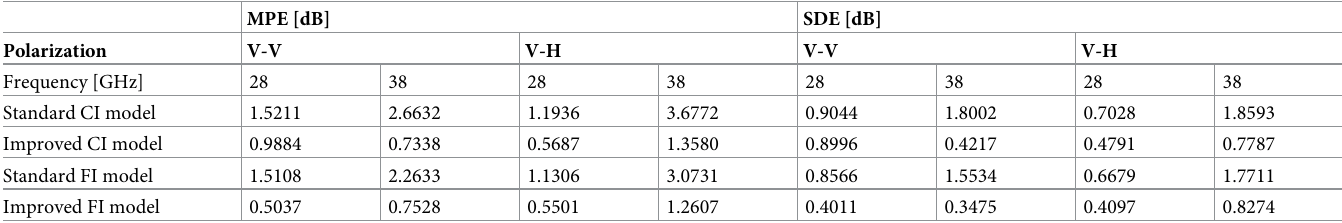
Table 6. MPE and SDE parameters for the LOS